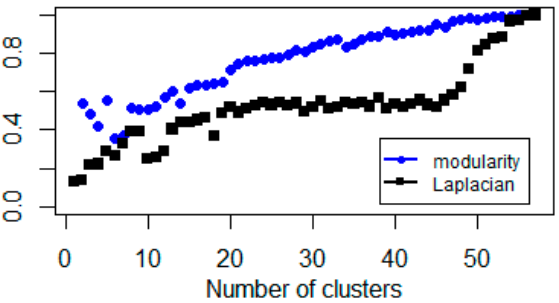
Figure 7. Explained percentage variance of Gaussian-kernel based clusters after zero out similarities less than 0.2.